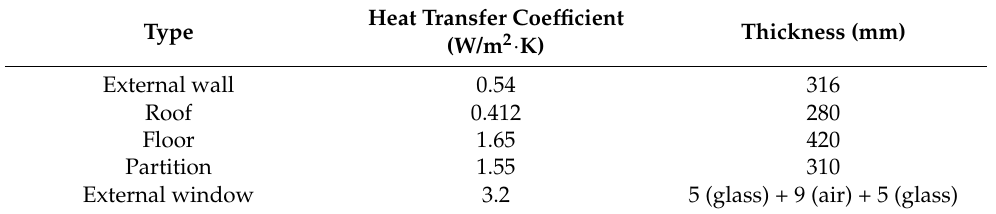
Figure 2. The selected typical office building in Lhasa: ( a ) north facade; ( b ) south facade; ( c ) west faced. Figure 3. The office room of the building selected: ( a ) the general layout of the office room; ( b ) the state of the office room; ( c ) the south windows and radiator. Table 1. The window-to-wall ratio of the office building.